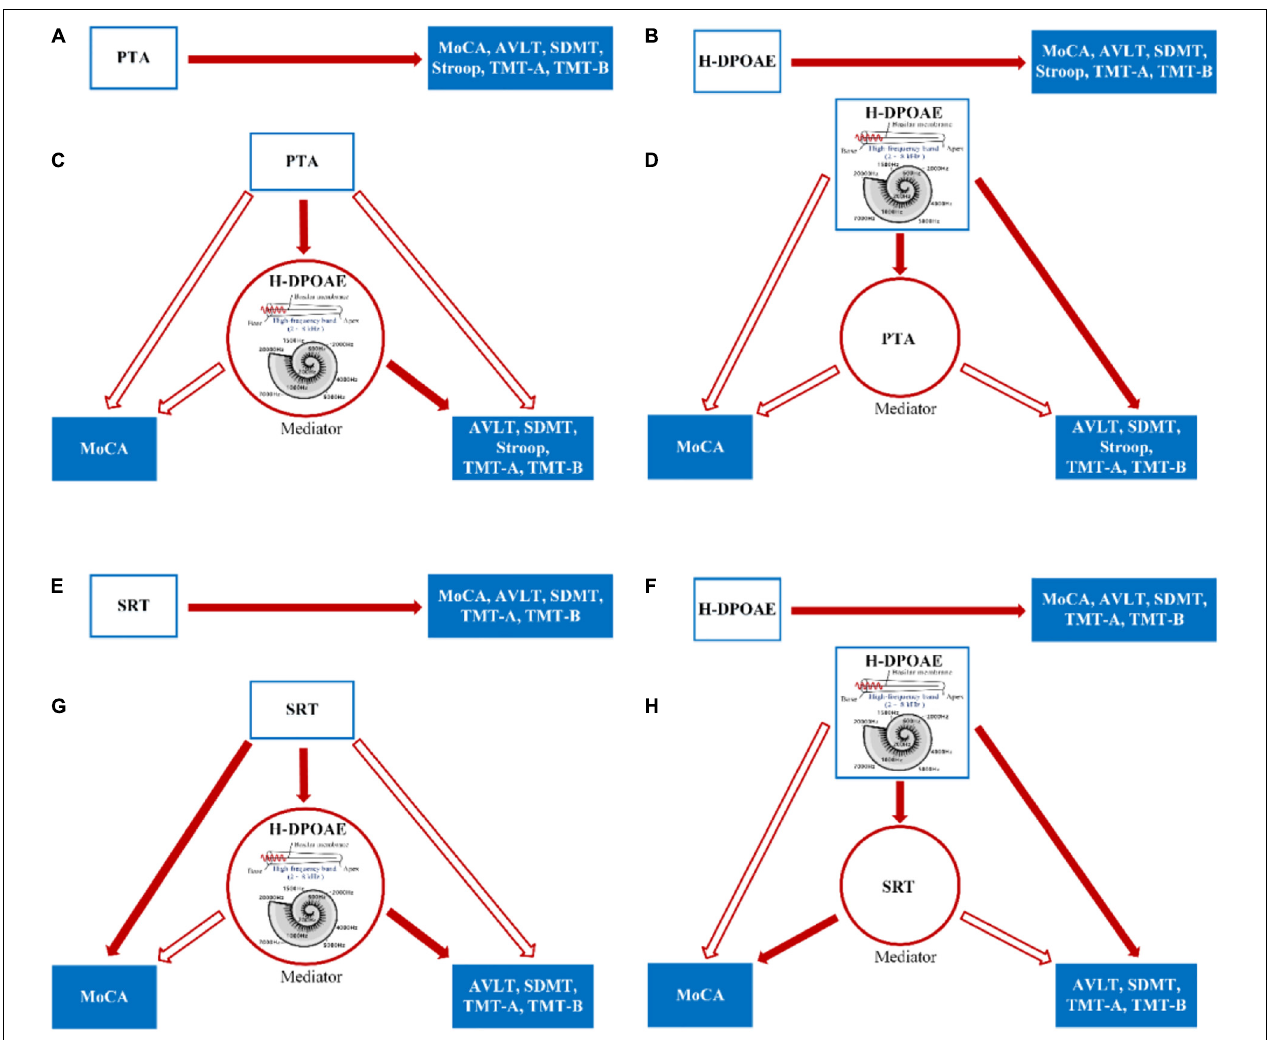
FIGURE 3 | The cascading mediation effects between H-DPOAE, PTA/SRT, and cognitive tests in all participants. (A) Total effect of PTA predicting cognition. (B) Total effect of H-DPOAE predicting cognition. (C) Mediation by H-DPOAE between PTA and MoCA, AVLT, Stroop, TMT-A, and TMT-B. (D) Mediation by PTA between H-DPOAE and MoCA, AVLT, Stroop, TMT-A, and TMT-B. (E) Total effect of SRT predicting cognition. (F) Total effect of H-DPOAE predicting cognition. (G) Mediation by H-DPOAE between SRT and MoCA, AVLT, TMT-A, and TMT-B. (H) Mediation by SRT between H-DPOAE and MoCA, AVLT, TMT-A, and TMT-B. Red solid arrows indicate the significant paths resulting in mediation, and red hollow arrows indicate the insignificance of paths. Blue hollow boxes indicate independent variables, red hollow circles indicate mediators, and blue solid boxes indicate dependent variables. H-DPOAE, high-frequency